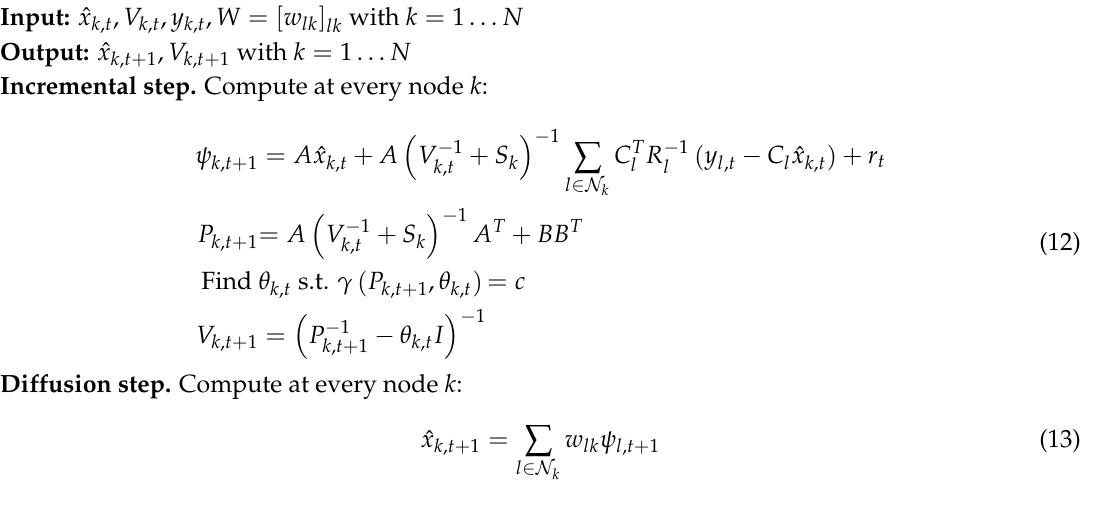
Algorithm 1 Distributed robust Kalman filter with uniform local tolerance at time t